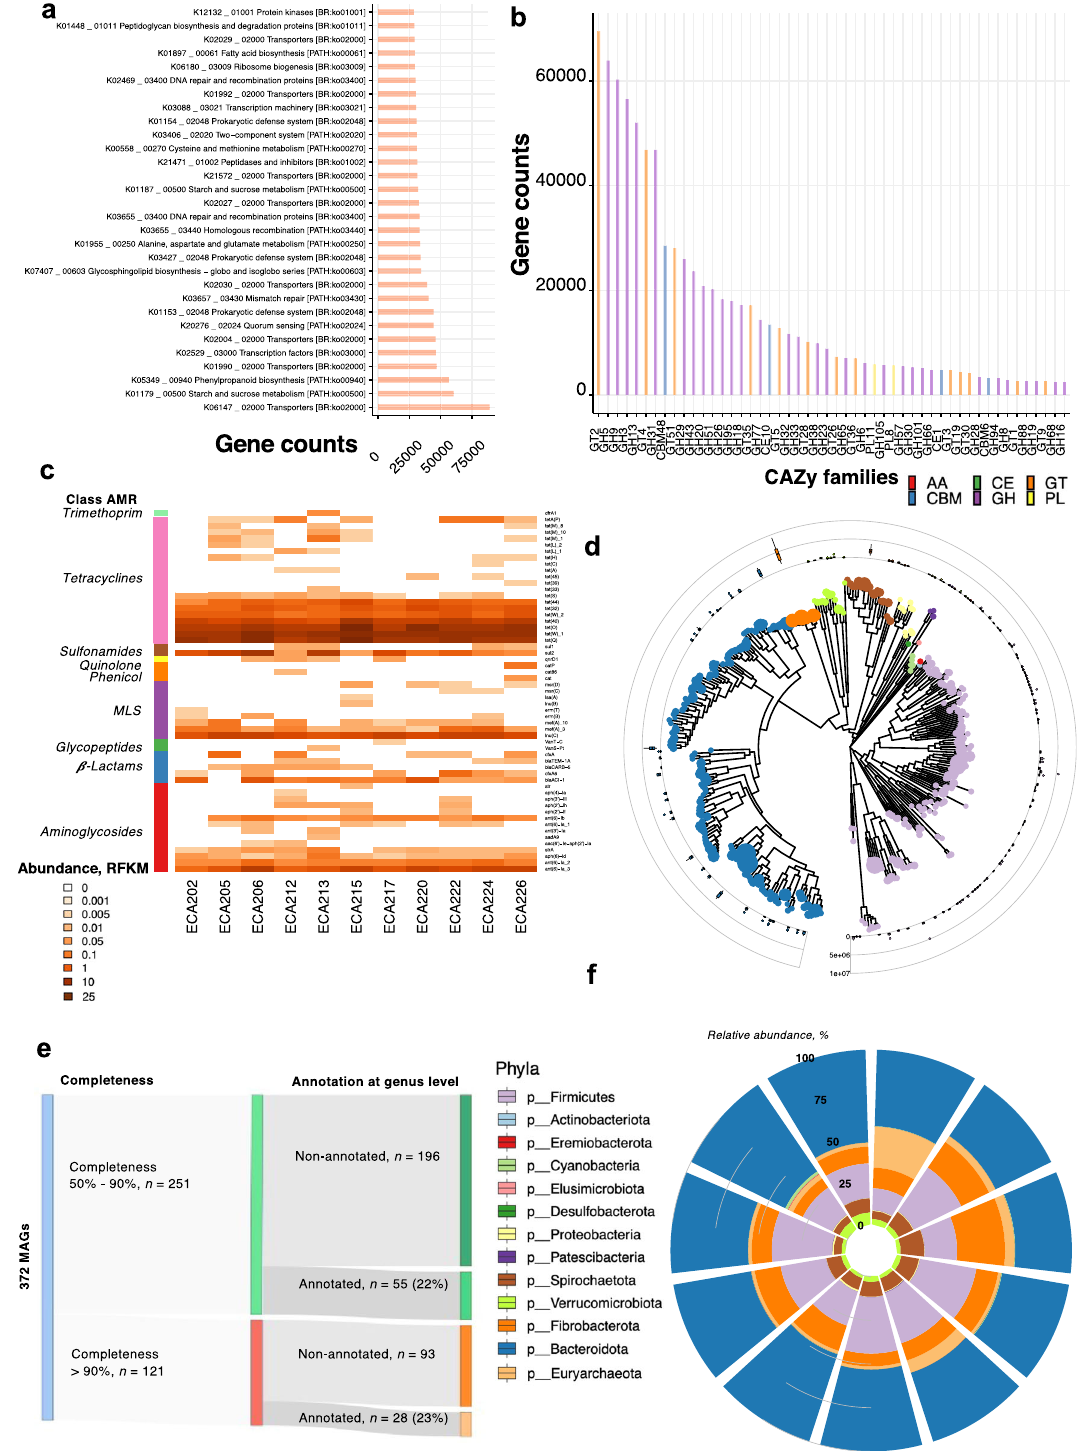
Fig. 2 Functional diversity of the equine microbial genes catalog, antimicrobial genes, and MAGs landscape. a Frequency of KEGGs pathways in the gut microbial gene catalog estimated from the orthologous groups (KOs). The horizontal bars represent the absolute number of genes found in each KEGG pathway. b The Frequency of total carbohydrate-active enzyme (CAZymes) families estimated in the gut microbial gene catalog. CAZymes are colored according to their class. c Heatmap shows each individual ’ s ( n = 11) normalized counts of antimicrobial resistance (AMR) genes based on the ResFinder database. The left column depicts the AMR class. d The Phylogenetic tree of the n = 372 MAGs detected. The outer cycle boxplots represent the abundance of each MAG. Boxplots are colored according to phyla. e Sankey diagram showing the numbers of MAGS with completeness between 50 and 90% or > 90%. Only a relatively small fraction of the MAGs (73 out of 372) was annotated at the genus level. f Circular stacked bar plot of the MAGs phyla abundance detected for each individual in the cohort ( n =